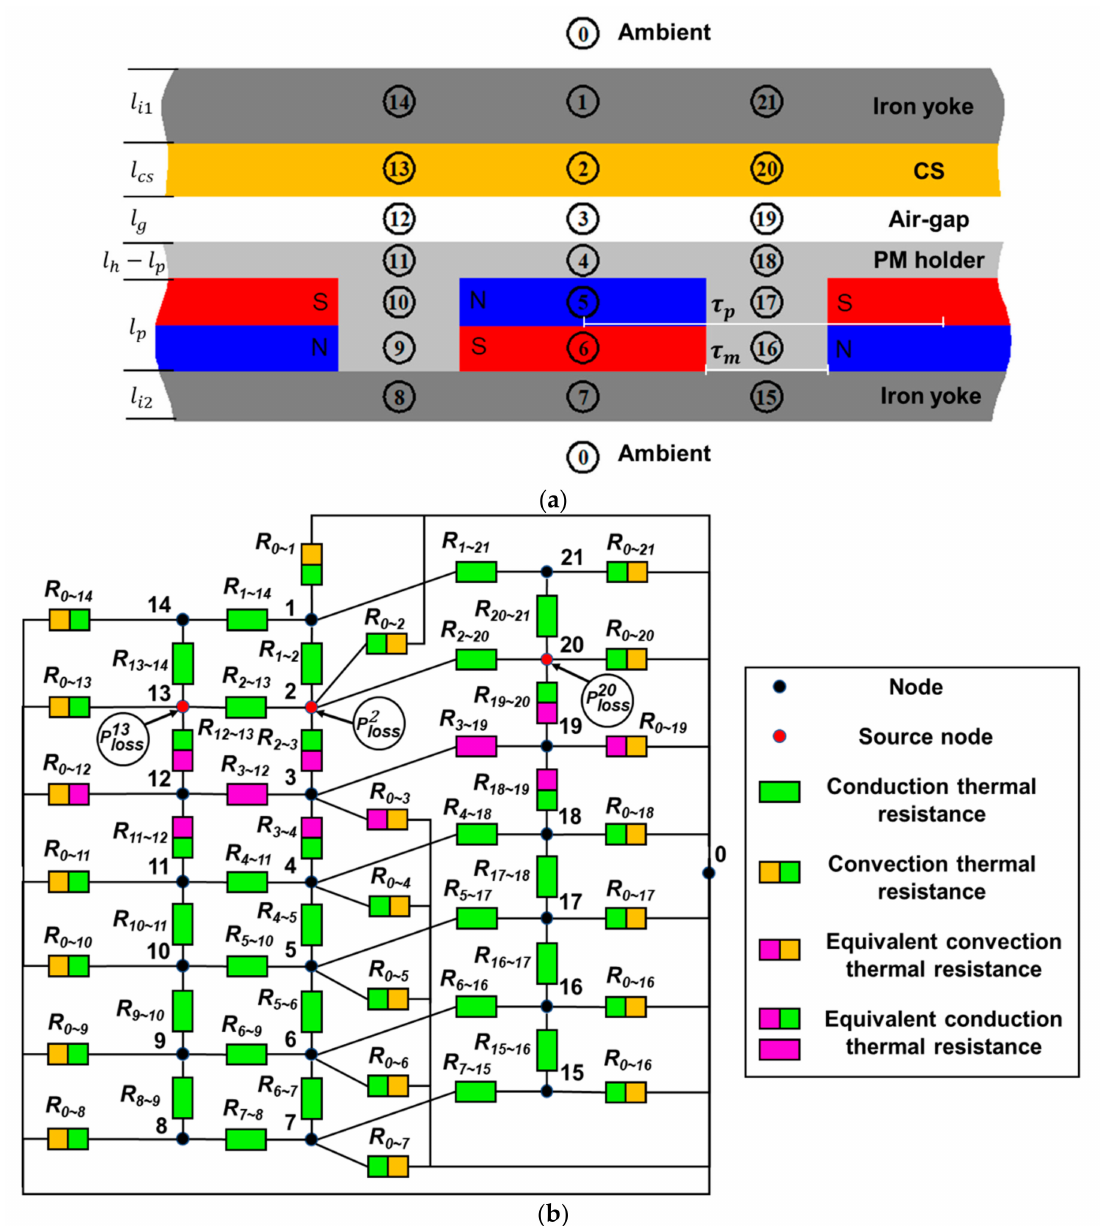
Figure 12. Proposed LPTN model: ( a ) thermal nodes distribution, ( b ) equivalent